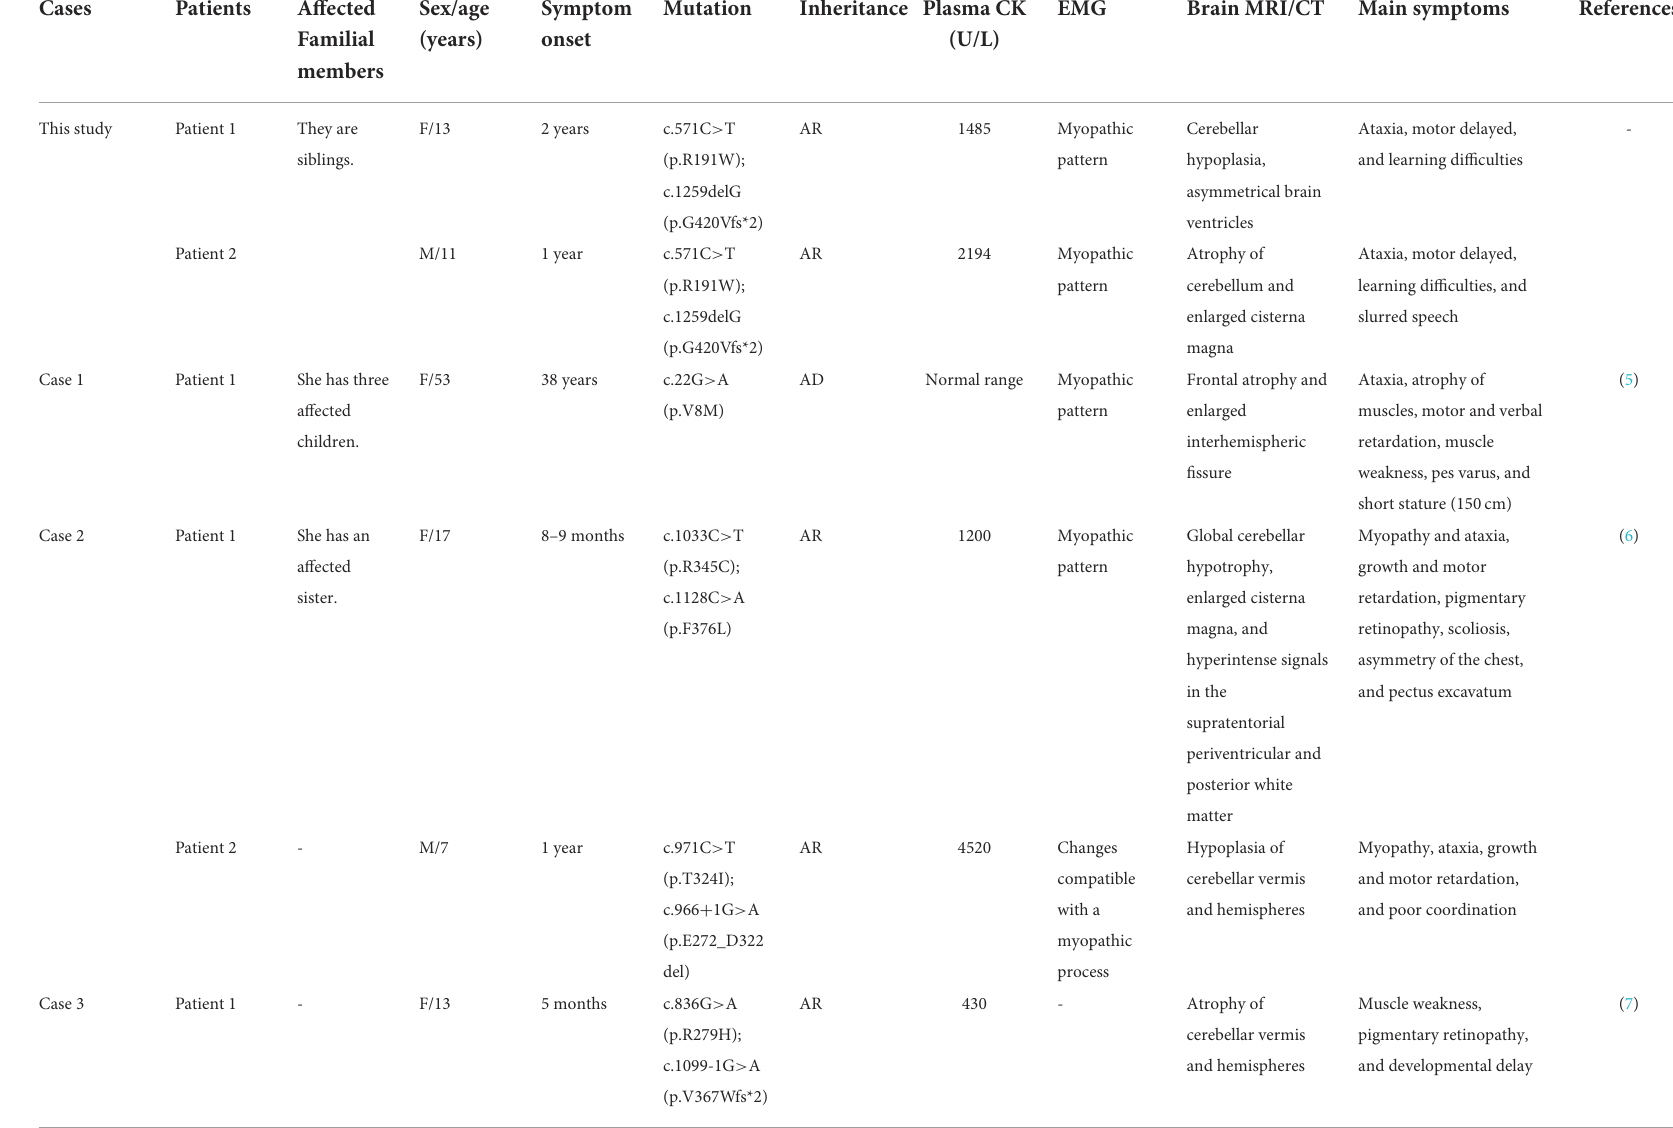
TABLE 1 Main clinical and genetic features of the patients with MSTO1